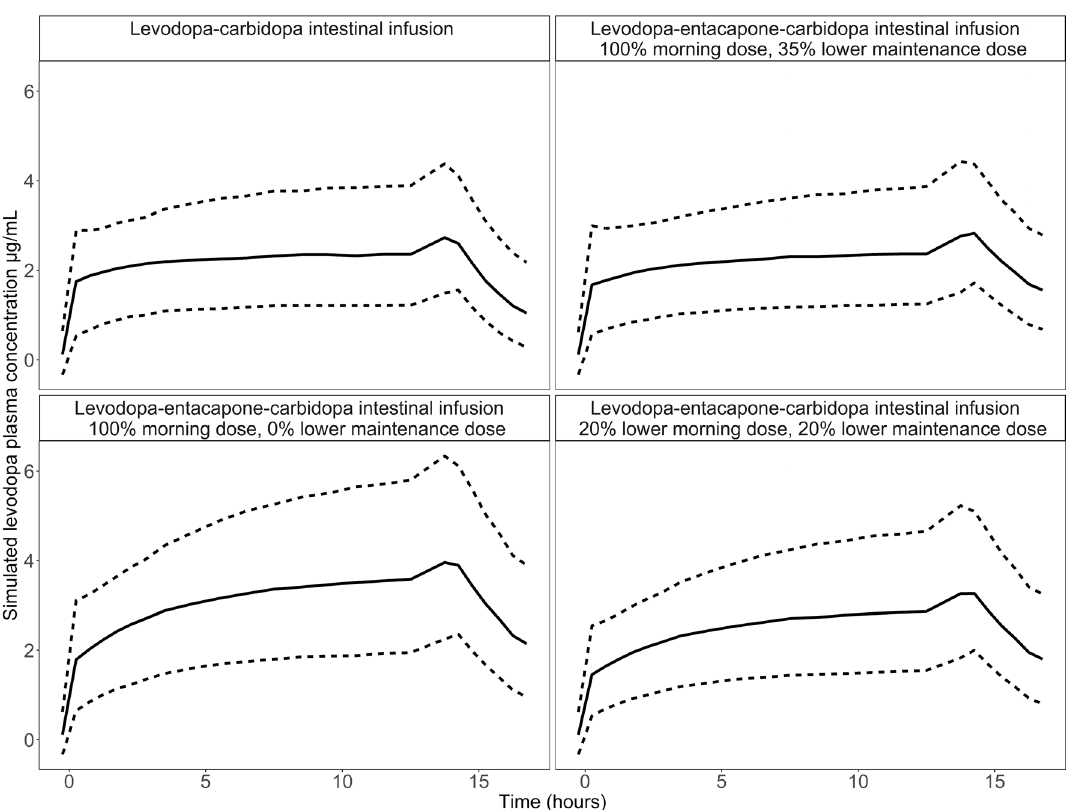
Figure 2. Simulated plasma concentration for the study population, with unchanged patient doses of LCIG as reference (top left plot) and decreased continuous doses for LECIG treatment by: 0% lower morning dose and 35% lower maintenance dose (top right plot), 0% lower morning and maintenance dose (bottom left plot) and 20% lower morning and maintenance dose (bottom right plot). The solid line represents the median of the simulated data, the top and bottom dashed lines represent the 10th and 90th percentiles of the simulated